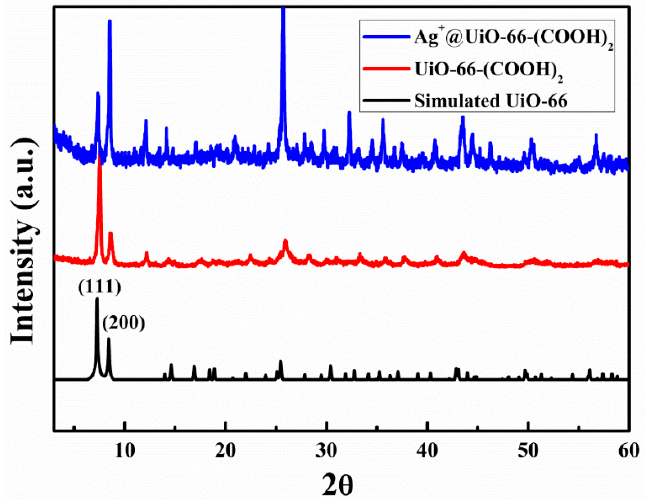
Figure 2. PXRD patterns of the simulated UiO-66, as-synthesized UiO-66-(COOH) 2 and Ag + @UiO- 66-(COOH) 2 .